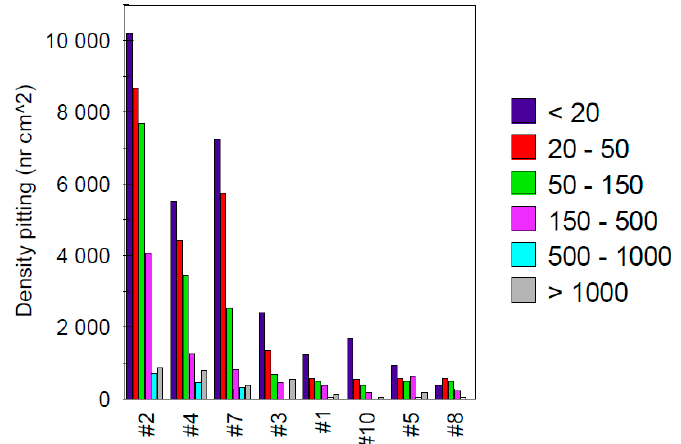
Figure 10. Number of pits counted by class, according to the size of the pit surface area.